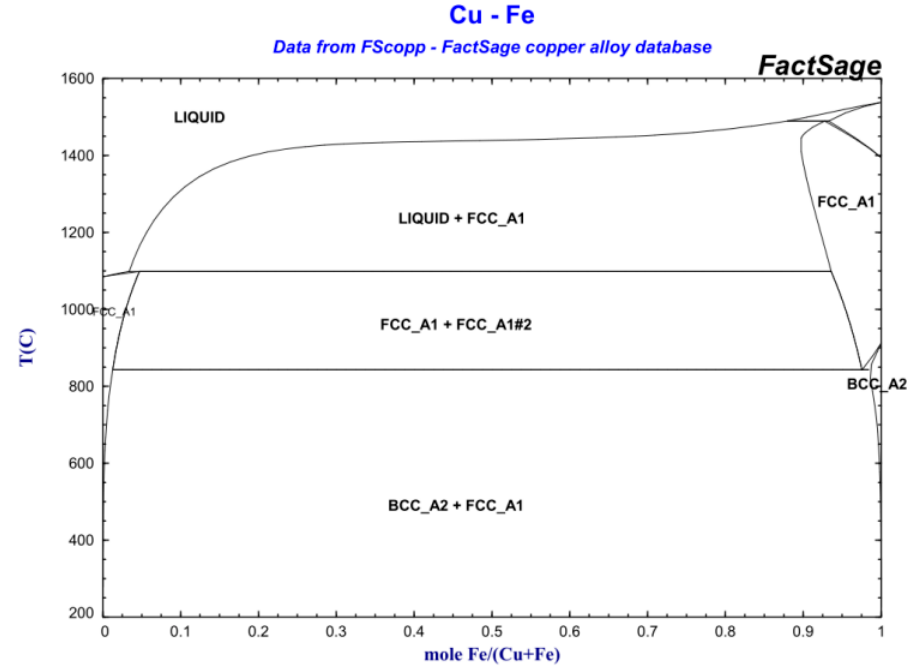
Figure 7. Cu-Fe binary phase diagram.